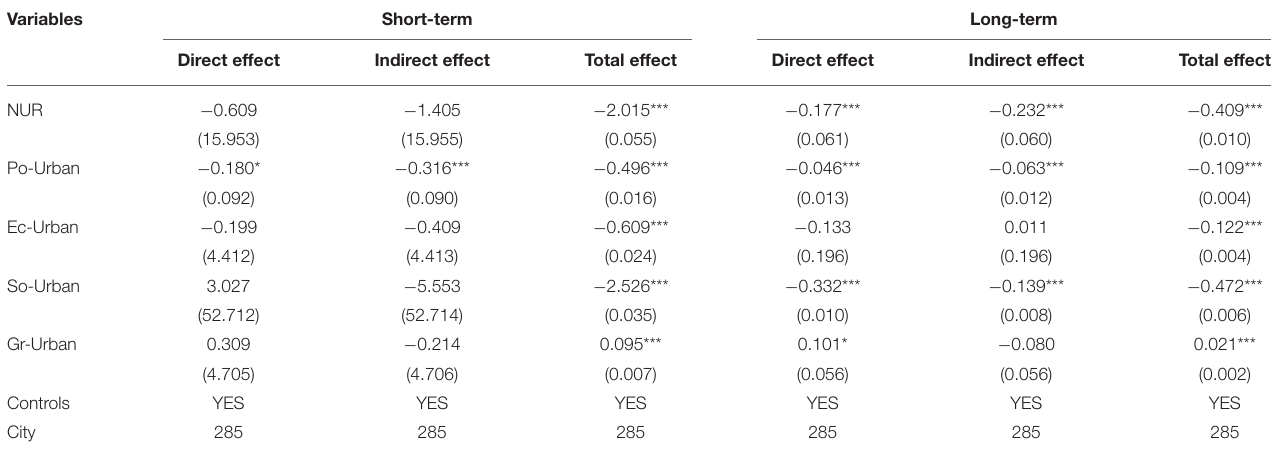
TABLE 7 | Direct and indirect effects of the dynamic